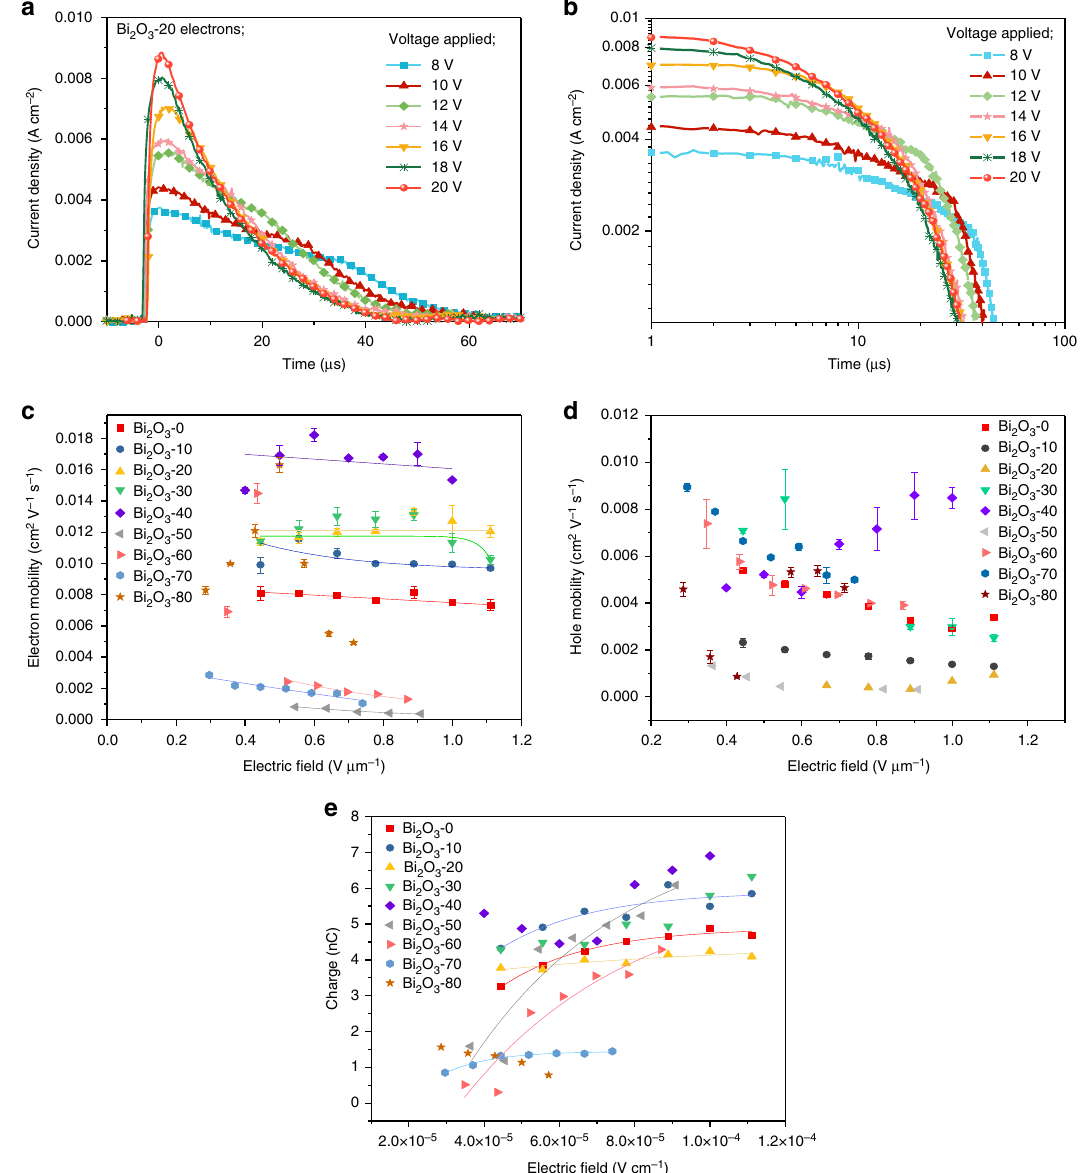
Fig. 5 Charge transport analysis. a Time-of- fl ight transients of electrons for the Bi 2 O 3 -20 device for the applied reverse-bias voltages from 8 to 20 V. b The double logarithmic plot of the time of fl ight transient presented in a . Electric fi eld dependency of c electron mobility (data have been fi tted to show the mobility dependency under the electric fi eld) and d hole mobility of devices from Bi 2 O 3 -0 to Bi 2 O 3 -80. Here, the error bars represent the range of three measurements carried out under each condition. e The collected electron charge for different devices based on a fi t to the Hecht